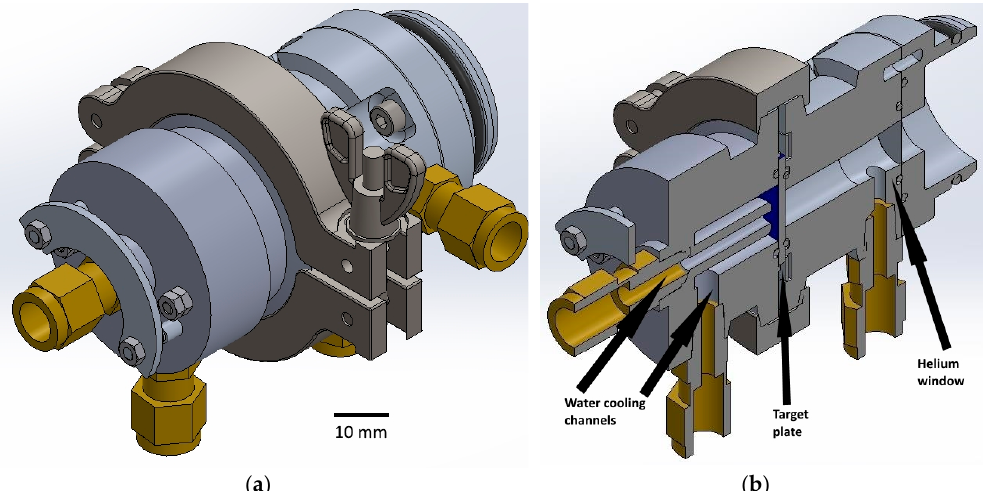
Figure 2. ( a ) New target system assembly in closed position. The water-cooling inlet line is attached to the axially centered fitting on the left; the water outlet is at the bottom left; the beam enters from the top right. ( b ) Cross-section showing the water-cooling channels, the helium-cooling window, and the target plate.